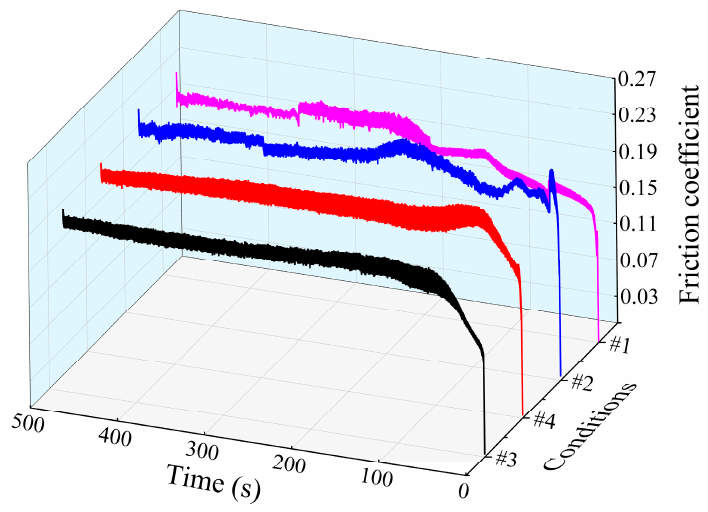
Figure 16. Variation in friction coefficient of different specimens with time.